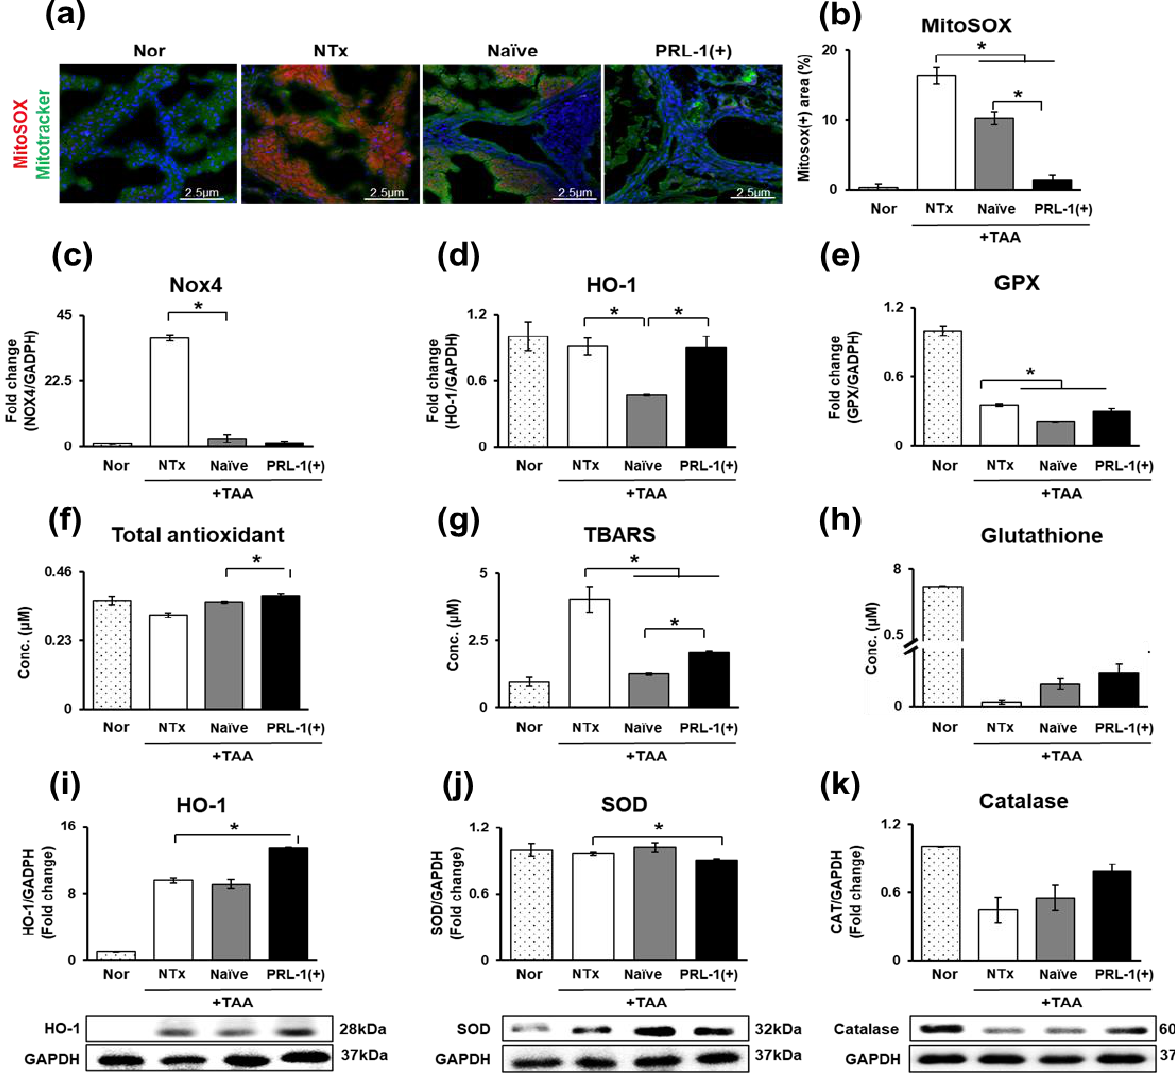
Figure 3. Expression of ROS in naïve and PRL-1(+) transplanted rat livers. The expression of Mi- toSOX in TAA-injured rat liver ( a ) MitoSOX and Mitotracker, ( b ) MitoSOX intensity. The expression of ROS in TAA-injured rat liver by qRT – PCR, ELISA and Western blot ( c ) Nox4, ( d ) HO-1, ( e ) GPx, ( f ) Total antioxidant, ( g ) TBARS, ( h ) Glutathione, ( i ) HO-1, ( j ) SOD, ( k ) CAT. All experiments were repeated in duplicate to triplicate. *p < 0.05.